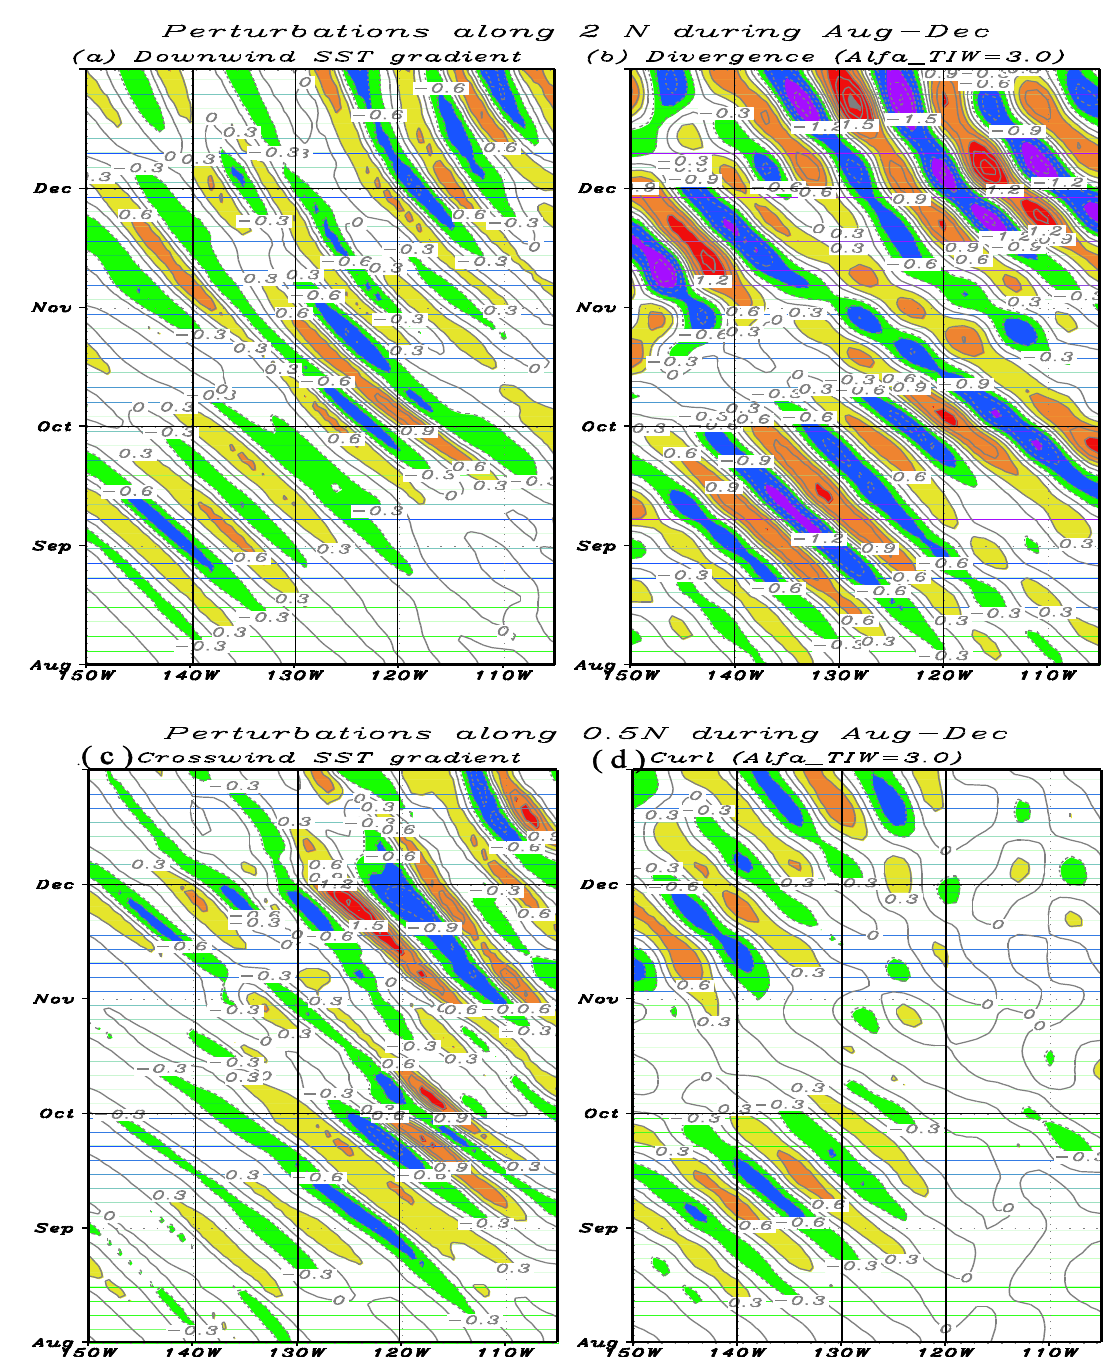
Figure 8. Time-longitude sections during August-December in the reference feedback run (α = 3.0 taken and the first 10 SVD modes retained): ( a ) the zonal-high-pass filtered TIW downwind component of the SST gradient along 2°N and ( b ) the corresponding wind stress divergence; ( c ) the zonal-high-pass filtered crosswind component of the SST gradient along 0.5°N and ( d ) the corresponding wind stress curl. The calculations are made from daily SST and τ fields in year 13. The contour is 0.3 °C per 100 km in (a,c), and is 0.3 N·m −2 per TIW 10 4 km in